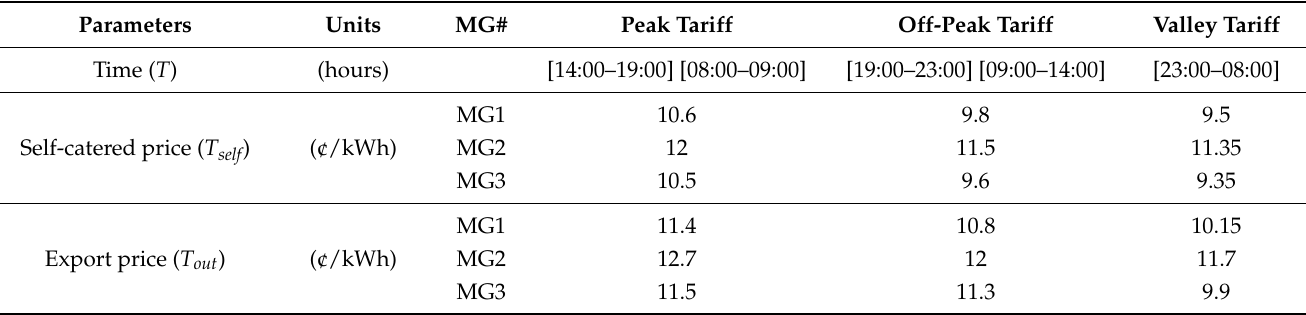
Table 3. Electricity Tariff Rates